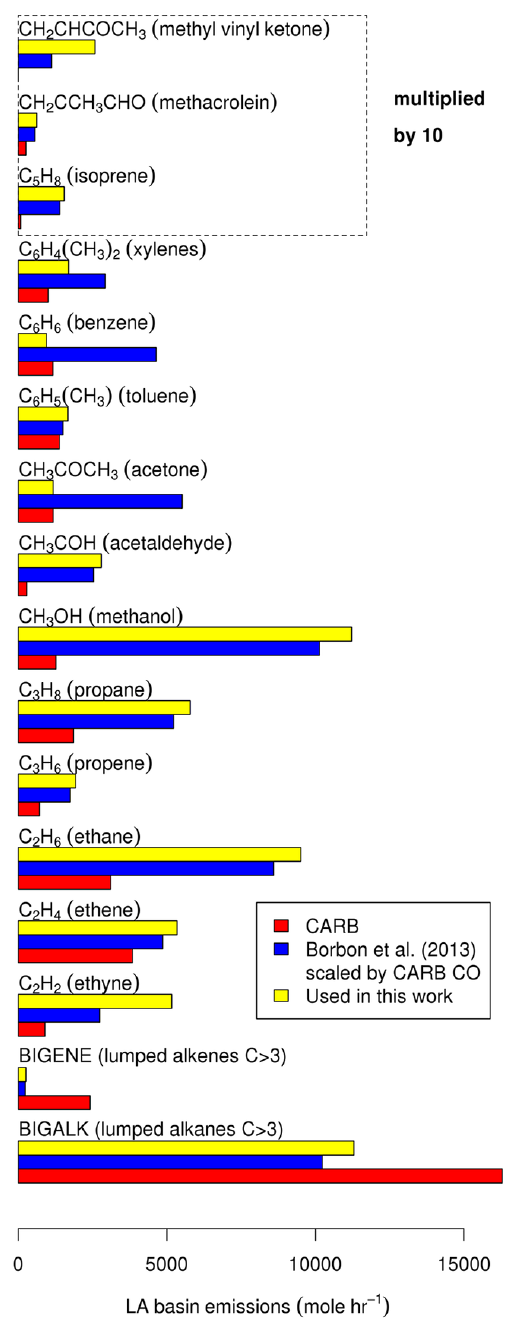
Figure 2. VOC emissions in the LA basin (rectangular box from 33.6 ◦ N, 119.0 ◦ W, to 34.3 ◦ N, 117.7 ◦ W) for selected MOZART-4 species as given by the CARB 2008 inventory (red), scaling factors in Borbon et al. (2013) multiplied by CARB 2008 CO emissions (blue), and the final emissions used, a result of the emissions prepa- ration procedure outlined in the text